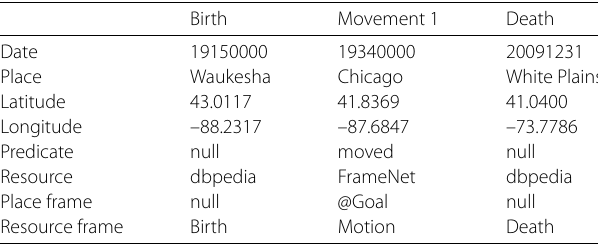
Table 3 Results obtained by processing Les Paul’s biography using the Ramble-On